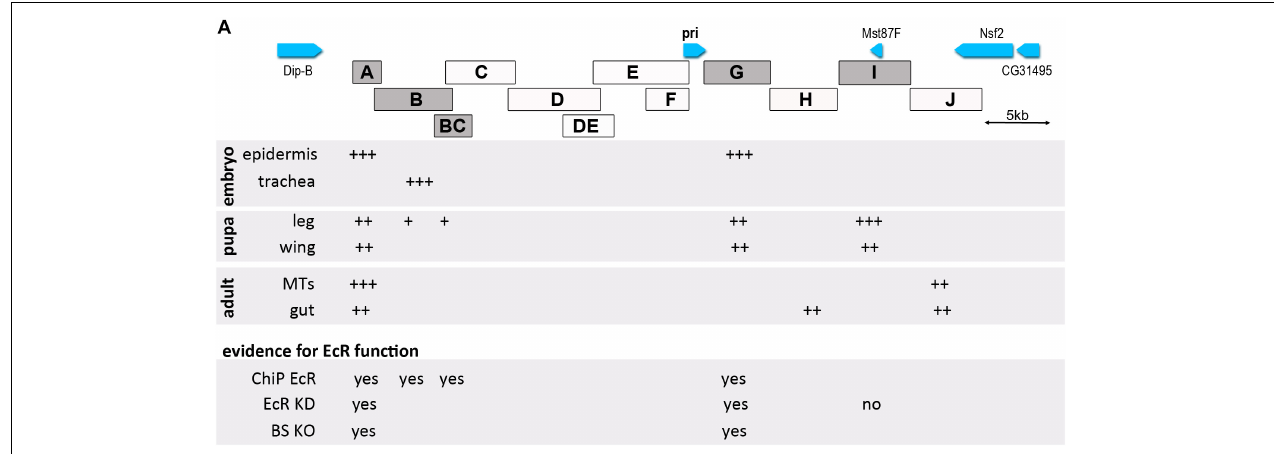
FIGURE 8 | Schematic representation of pri enhancer activity along Drosophila development. The detected activity of pri enhancers is shown by a + sign, their number depending on the intensity of the activity. Data for embryo and pupa are from this paper and from Bohère et al. (2018) and Al Hayek et al. (2021) for adult tissues [adult stem cells of Malpighian tubules (MTs) and of the gut]. For positive enhancers, we visualized EcR binding (ChiP EcR), effect of EcR function depletion on enhancer activity (EcR KD) and activity of enhancers mutated on specific EcR binding sites (BS